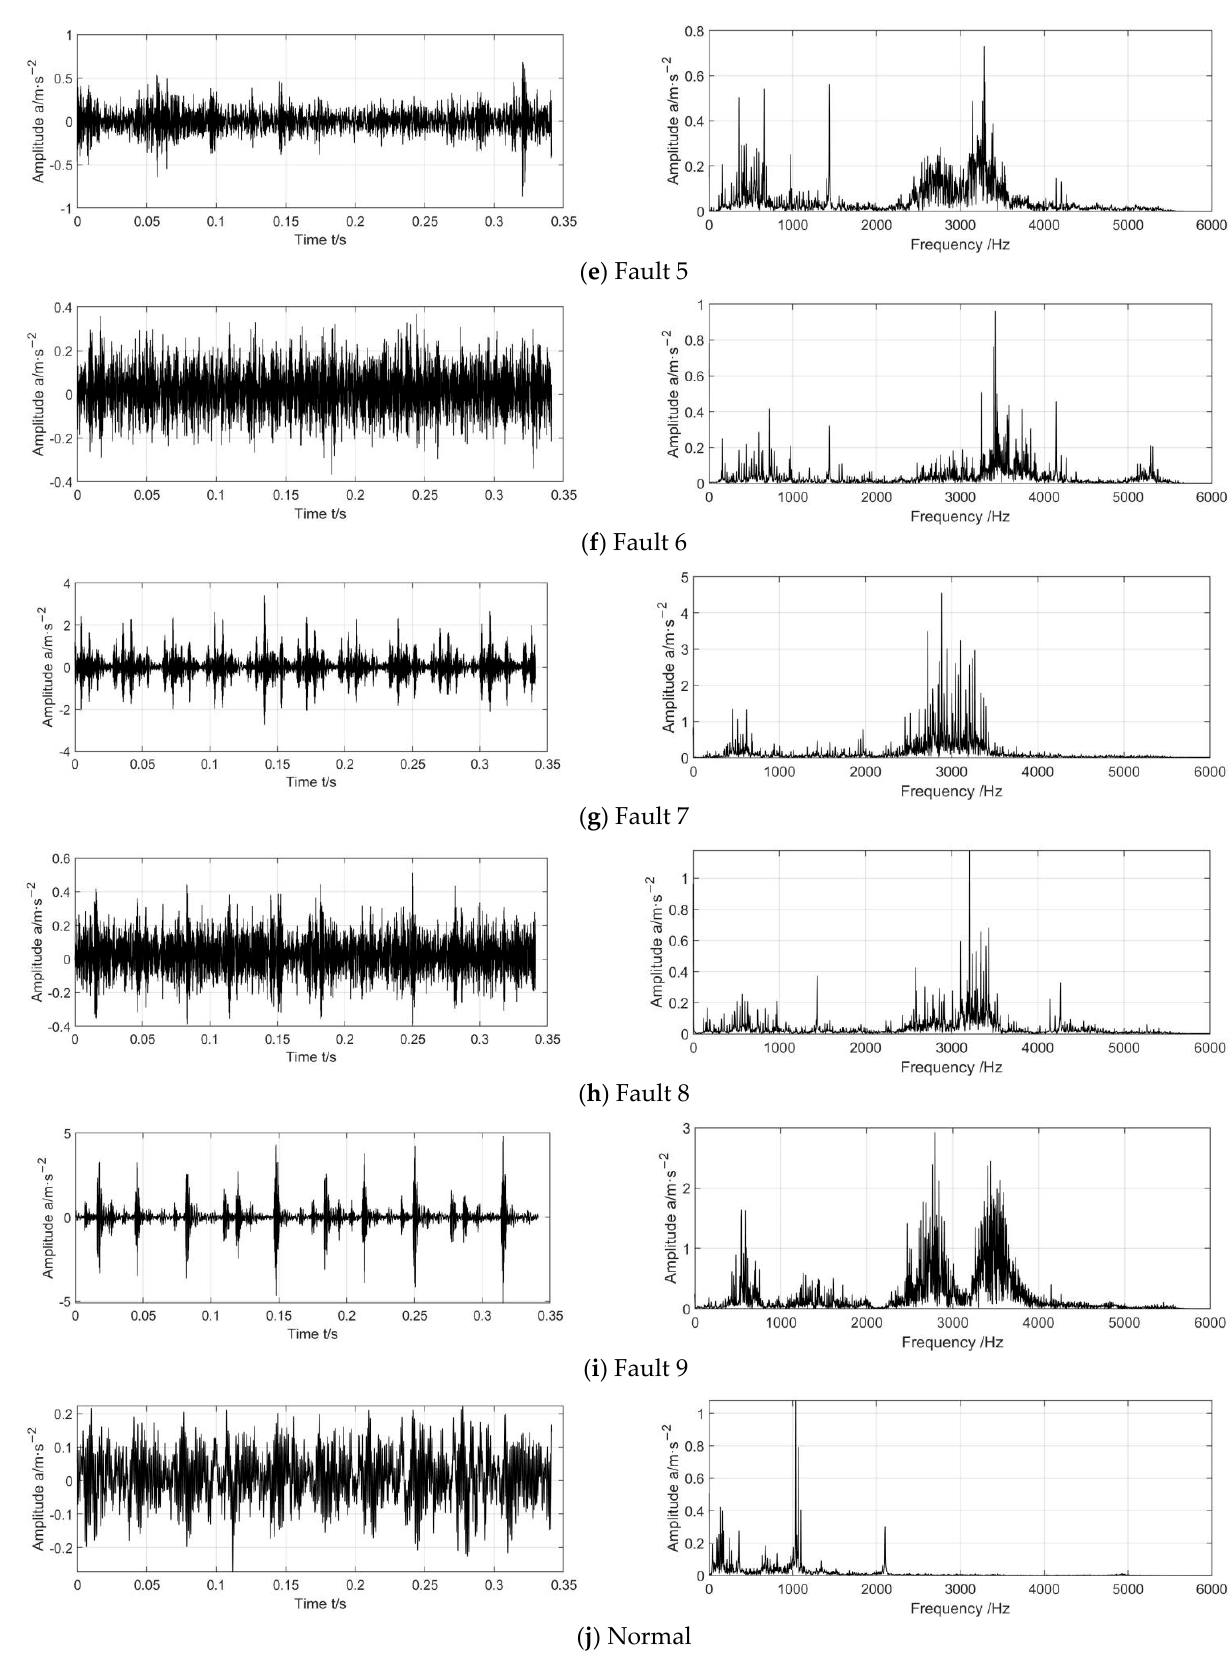
Figure 8. Time and frequency domain waveforms of bearing operating conditions.